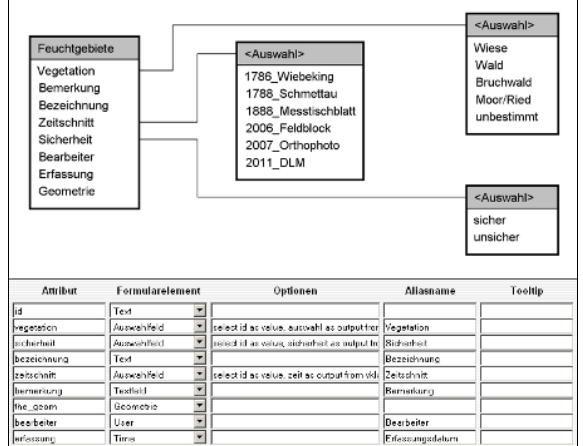
Figure 5. Thematic data model for swamp